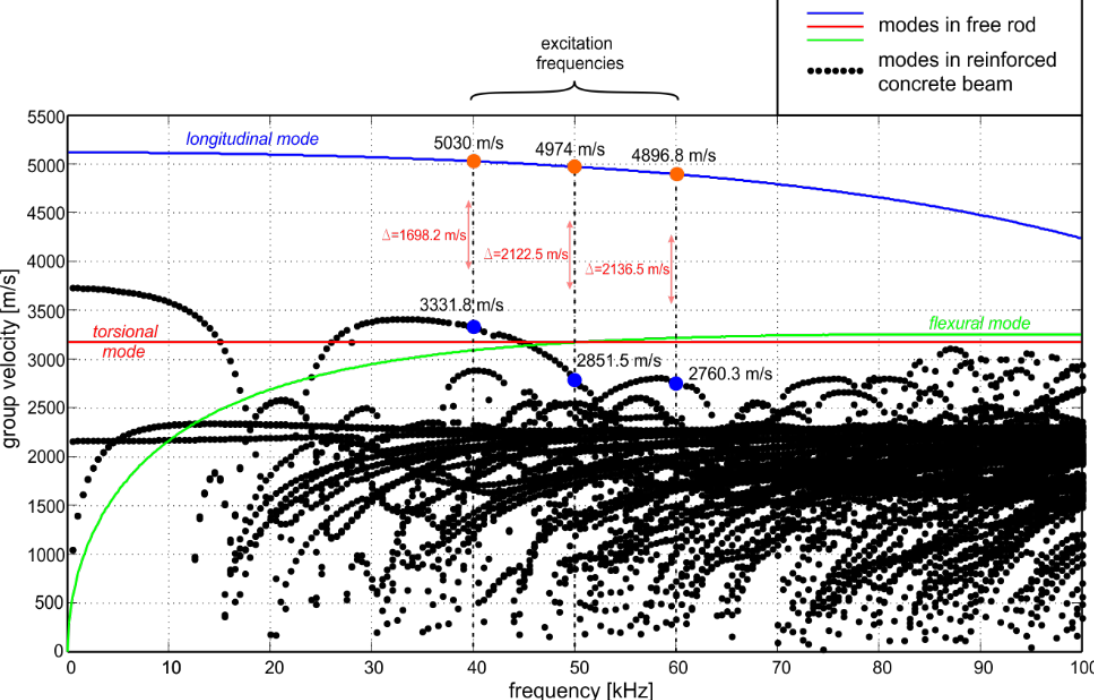
Figure 3. Group velocity dispersion curves of 2 cm diameter steel bar (E = 207 GPa, v = 0.3, and ρ = 7894 kg/m 3 ) obtained analytically (solid lines) and dispersion curves for rectangular reinforced concrete cross-section (steel: E = 207 GPa, v = 0.3, ρ = 7894 kg / m 3 , concrete: E = 29 GPa, v = 0.2, and ρ = 2306 kg/m 3 ).